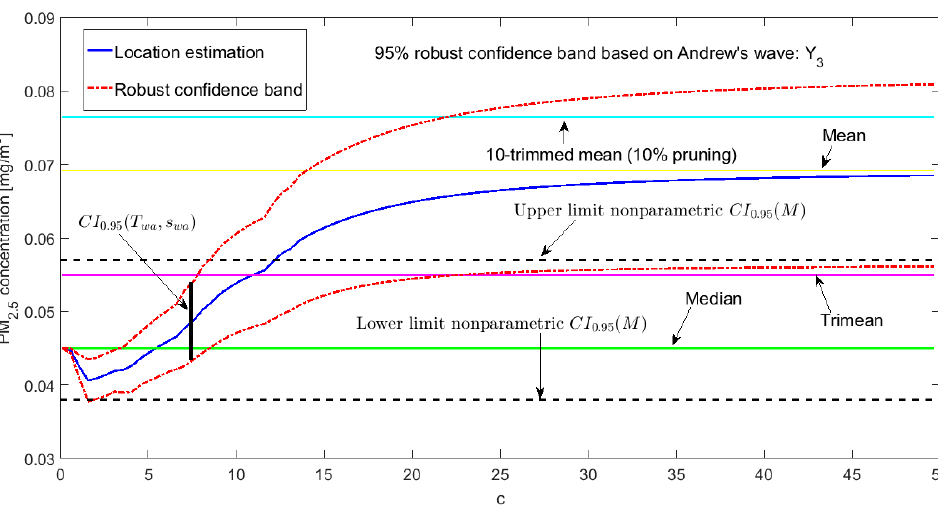
Figure 16. 95% robust confidence band based on the biweight estimators: 𝑌 (cid:2871) . 4. Conclusions In this article, a response has been given to a problem that was pending to be solved in previous research articles [13]. Specifically, robust confidence intervals were found for PM 2.5 concentration measurements in the urban park called La Carolina, Quito, Ecuador. The main contributions of this article were that different techniques were applied for the construction of robust confidence intervals, that their results were compared, and that the results of the design of these robust intervals were applied to analyze whether the six variables considered in the study came from the same distribution, establishing the differences between the parameters that characterized those variables. For the construction of the confidence intervals, the classical, non-parametric, bootstrap, and, mainly, several pairs of robust statistics were used. Classic confidence intervals make use of the hypothesis that the observations come from a Gaussian, or approximately Gaussian, distribution. However, what happened was that the variables that were given contained numerous observations with extreme values on the right, which did not meet the hypothesis that was assumed. From the analysis of the variables under study, the following was concluded: (1) the median of 𝑌 (cid:2871) was greater than that of all other variables; (2) the median of 𝑌 (cid:2870) was different from all the medians of the other variables; (3) the medians of 𝑋 (cid:2869) and 𝑋 (cid:2870) could be the same but different from all others (that is, lower than the median of 𝑌 (cid:2871) but greater than the median of the other variables); and (4) the